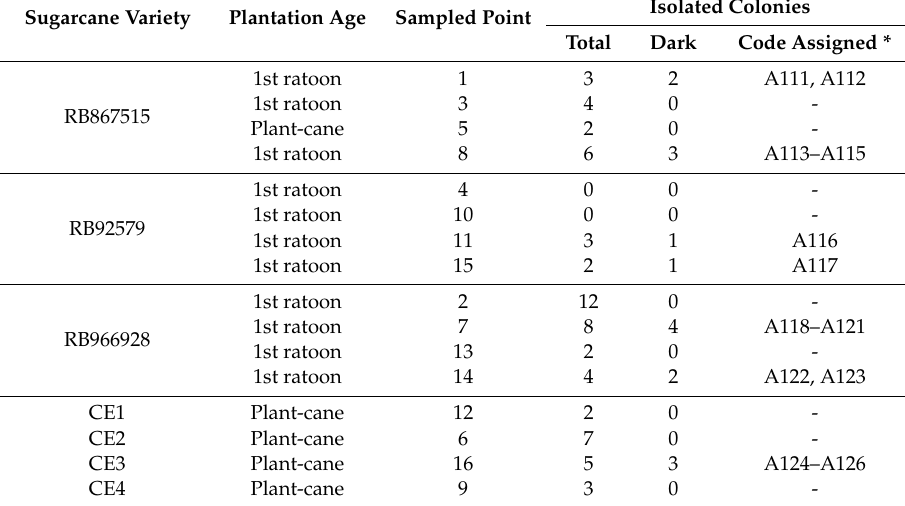
Table 2. Sugarcane variety, age of the plantation, and number of isolates (total and dark-colored). Plants grown in the sugarcane producing region of Quat á , S ã o Paulo, Brazil. Isolated Colonies Sugarcane Variety Plantation Age Sampled Point Total Dark Code Assigned